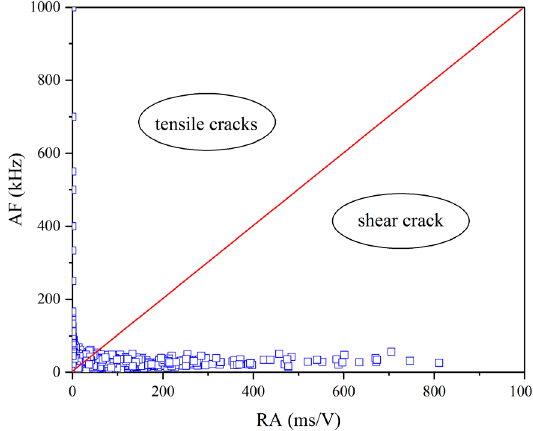
Figure 5. Distribution of AE parameters of RA versus AF.